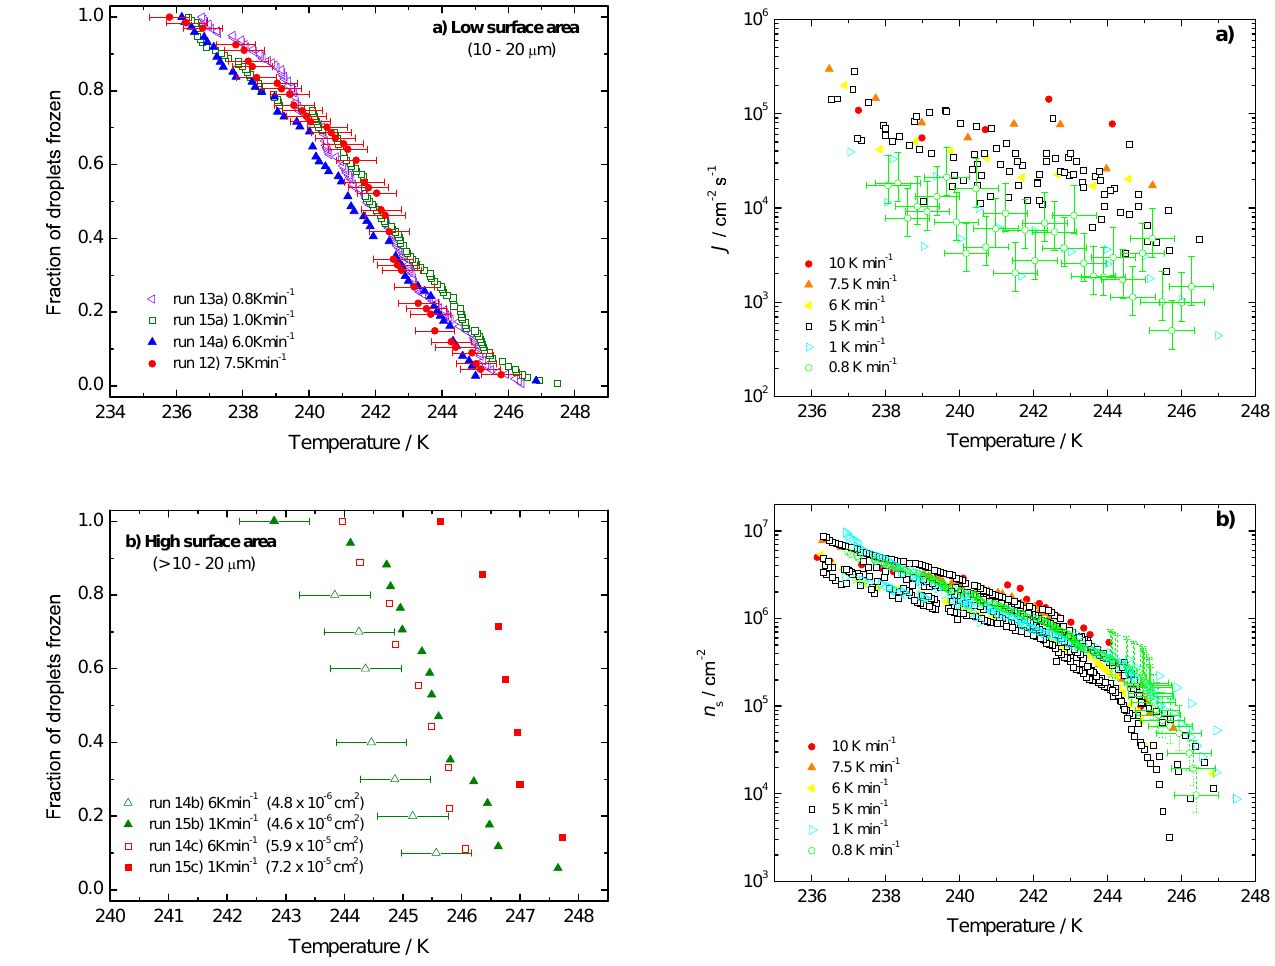
Fig. 5. ( a) Fraction of frozen droplets containing ∼ 0.05wt% illite as a function of cooling rate for droplets in the 10–20µm size bin ( s = 9 . 1 × 10 − 7 – 1 . 4 × 10 − 6 cm 2 ) . ( b) Fraction of frozen droplets containing ∼ 0.05wt% illite as a function of cooling rate for size bins > 10–20µm (14b: 21–34µm, 15b:=21–36µm, 14c:=42– 72µm, 15c: 44–80µm). See Table 3 for further details. Fig. 5a (surface area ∼ 1 × 10 − 6 cm 2 ), varying the cooling rate between 0.8 and 7.5 K min − 1 did not produce a signifi-